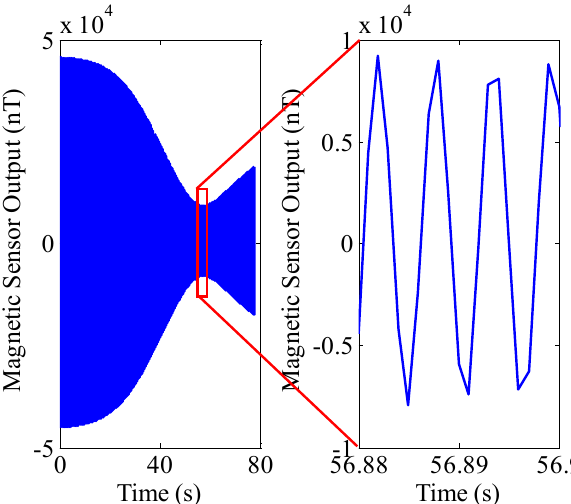
Figure 13. The output of the radially oriented MR sensor from a simulated trajectory. The right figure is a local enlarged drawing of the MR sensor output.